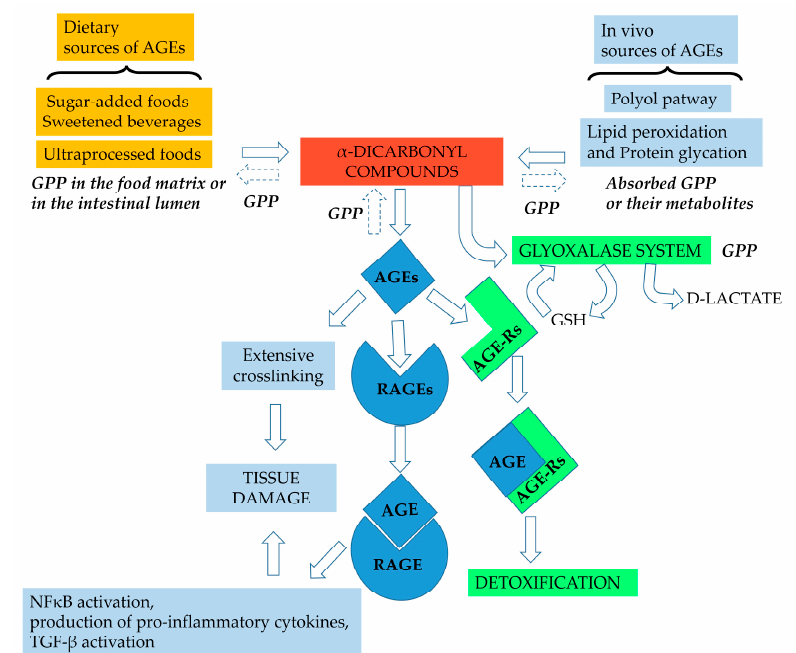
Figure 2. Potential sites of action of grape pomace phenolics (GPP) in the glycation pathway. In the food matrix during processing and in the intestinal lumen, GPP can inhibit α -dicarbonyl compounds and AGE formation by acting as metal chelators, antioxidants and carbonyl trapping agents. Absorbed GPP or their metabolites can exert the same activities in vivo; moreover, GPP can assist the detoxifying process in vivo by acting as a glyoxalase inducer. GSH, reduced glutathione; NF κ B, nuclear factor kappa-light-chain-enhancer of activated B cells, TGF- β transforming growth factor β .